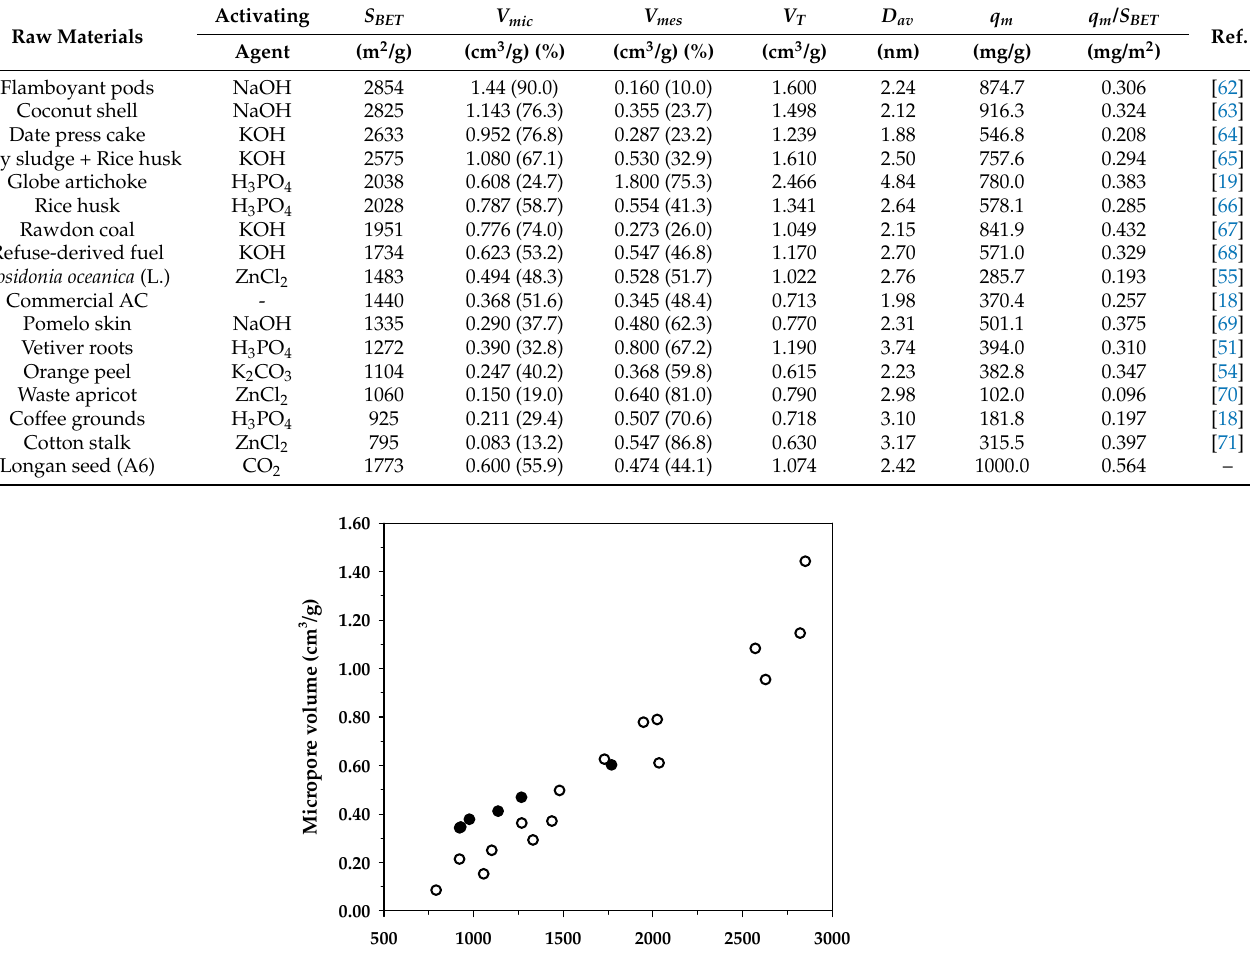
Table 8. The maximum adsorption capacity of methylene blue from solutions ( q m ) by activated carbons prepared from various materials and activation methods.